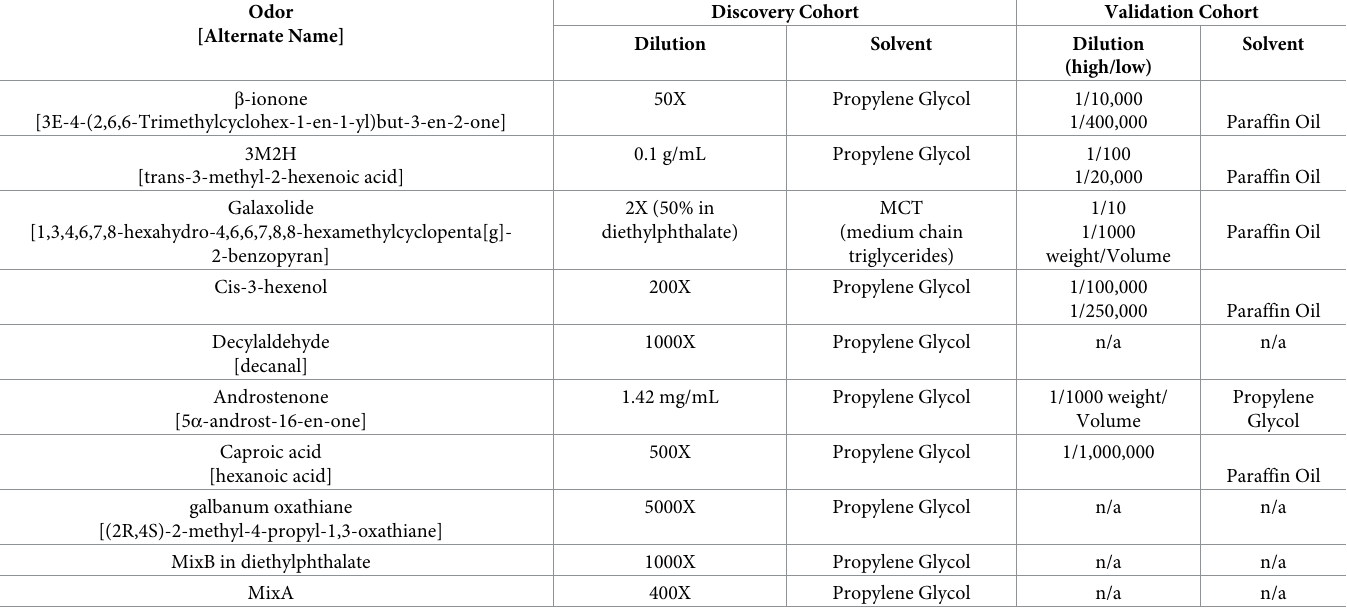
Table 2. Concentrations of Odors from the Discovery and Validation